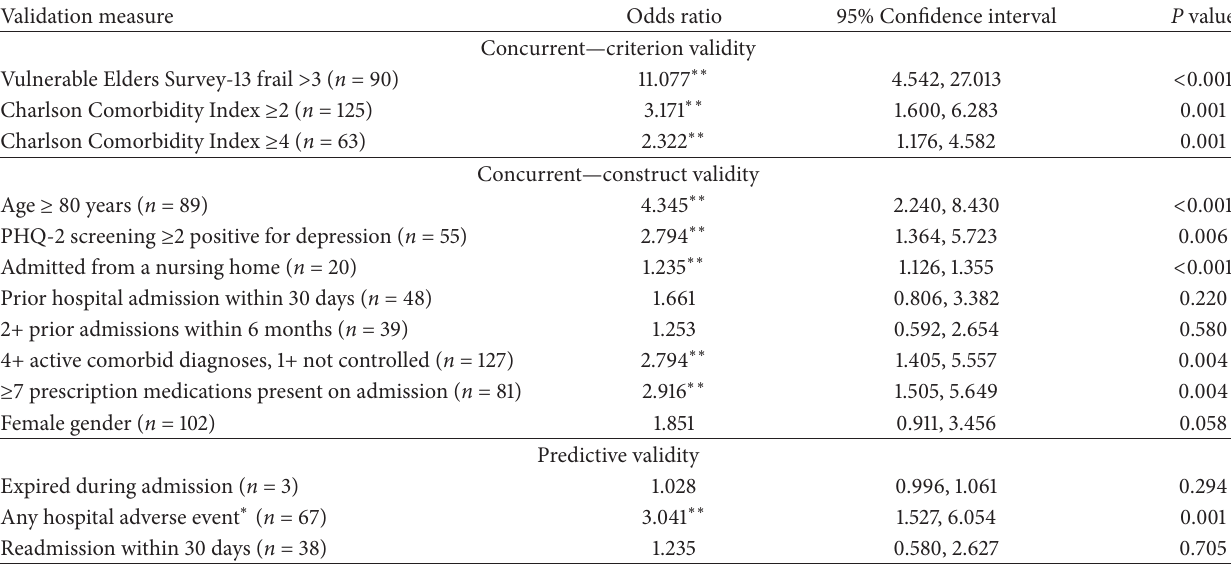
Table 3: Odds associated with positive frailty screen and selected validation measures ( N =